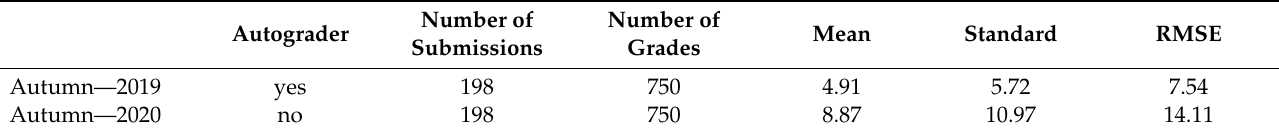
Table 5. Experimental results of the game process with and without autograder. Number of Autograder Submissions